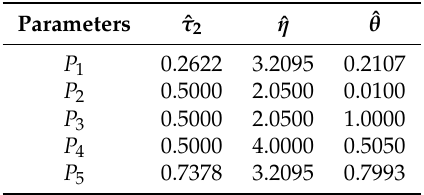
Table 3. Simulation parameters sets for performance and robustness analysis.